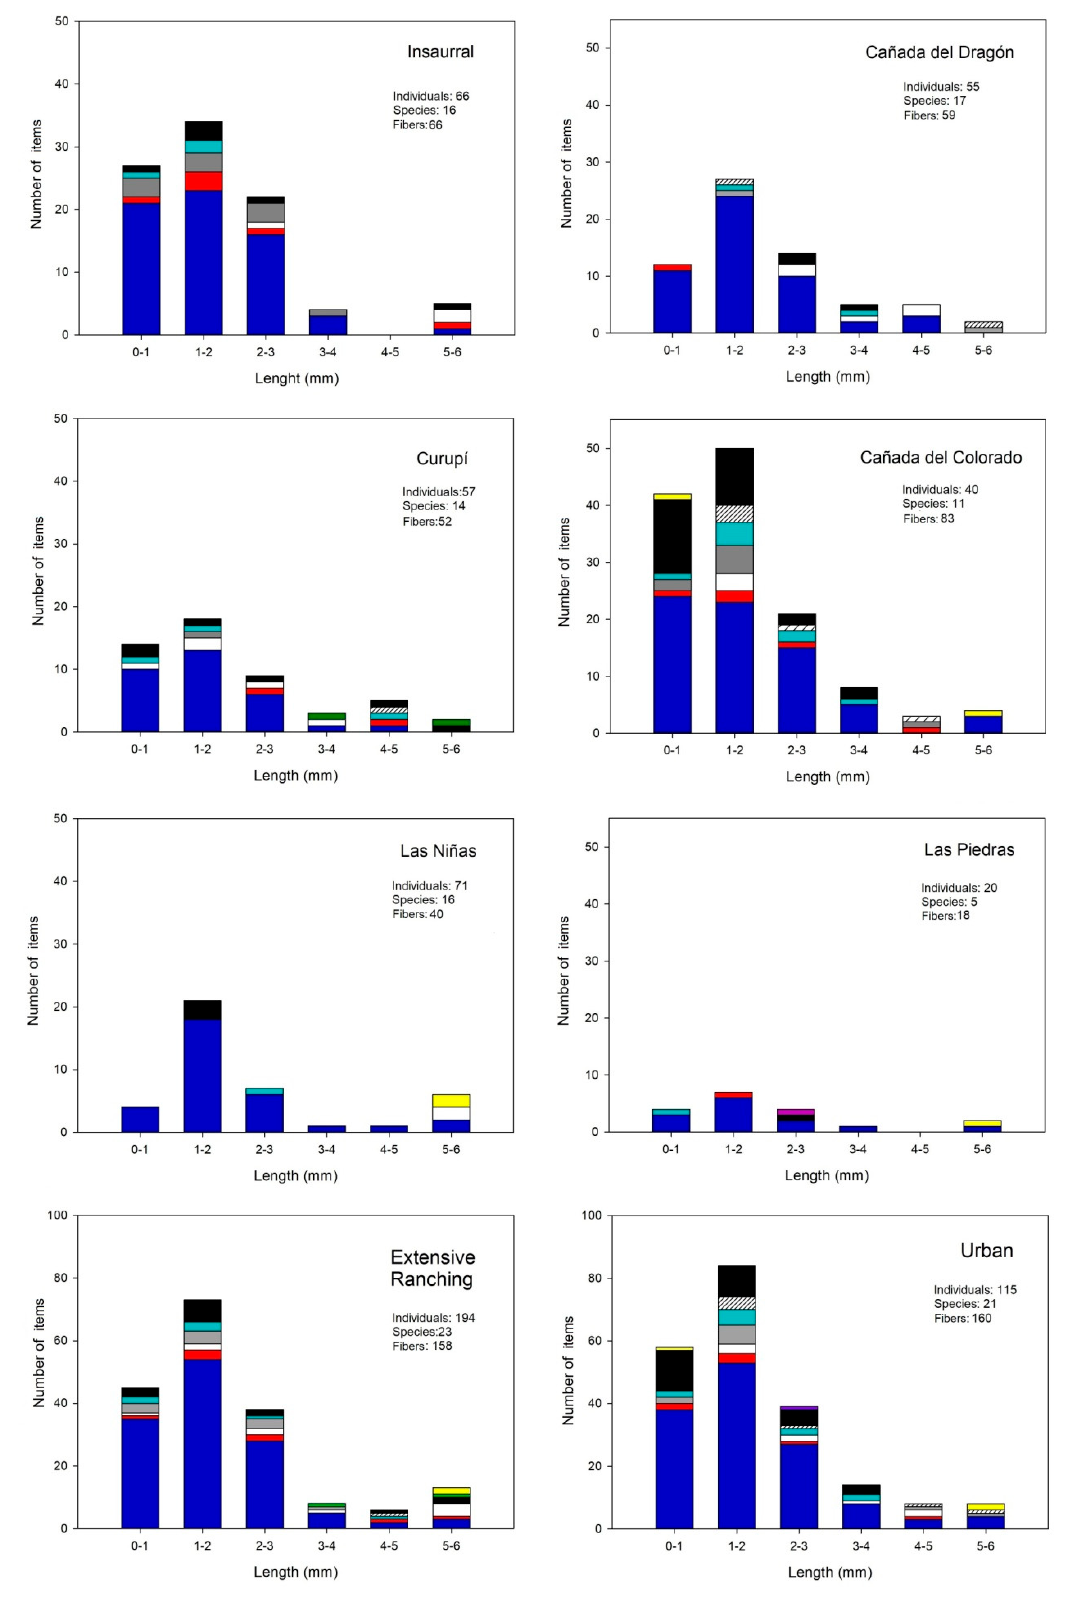
Figure 4. Size distribution of the plastic fibers found and their colours for each stream and for the groups (Extensive Ranching and Urban). Each graph also contains information about the amount of individuals analyzed, species and fibers collected.